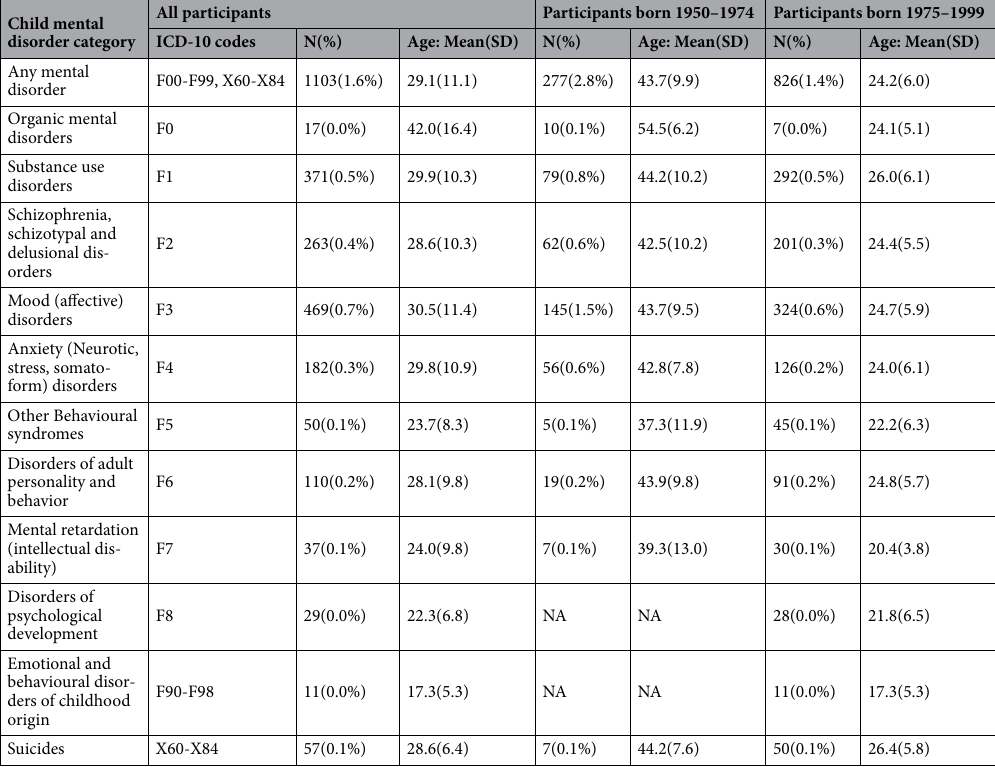
Table 2. The prevalence of and diagnostic codes for and the mean age at first diagnosis for the different offspring mental disorders in the whole cohort and among participants born 1950–1974 and 1975–1999. N refers to the number and % to the percentage of cases with each diagnosis. ICD-10 codes refer to the International Classification of Diseases, Tenth Revision (ICD-10) diagnostic codes for each mental disorder diagnosis. Age refers to the age at first mental disorder diagnosis in years. SD standard